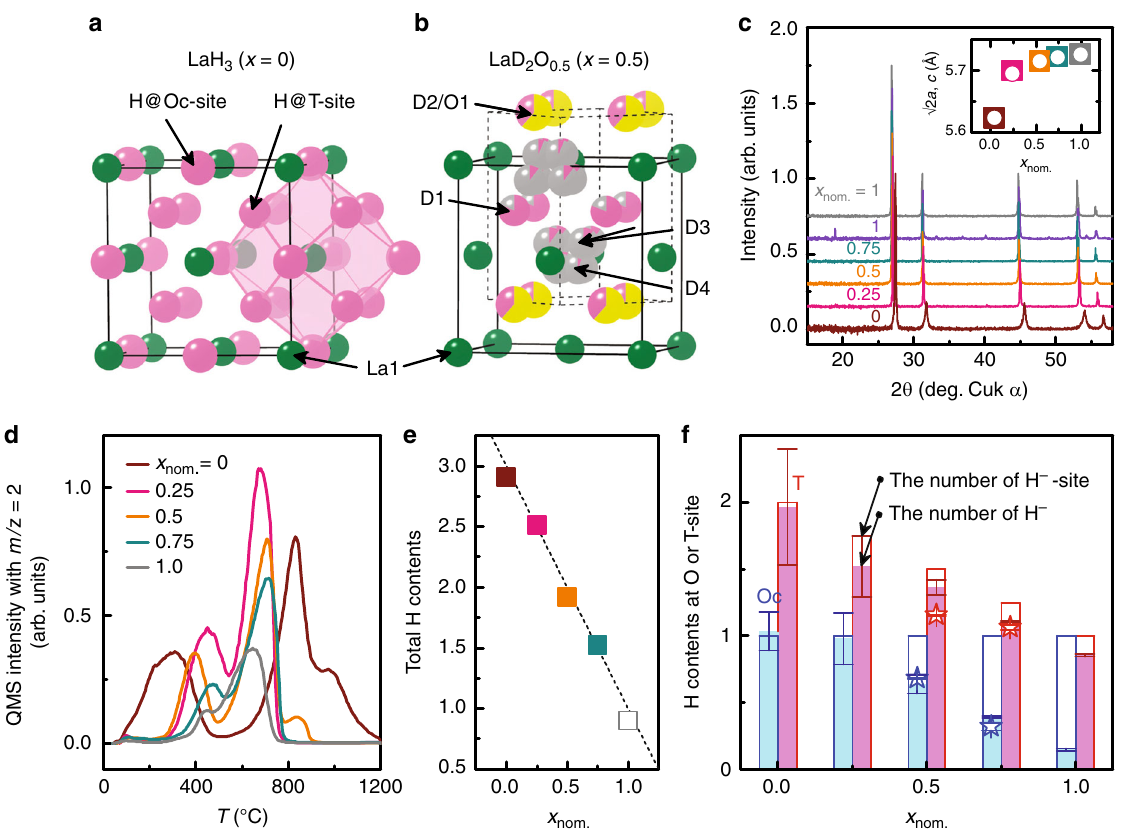
Fig. 1 Structural and compositional analyses for LaH 3-2 x O x and LaD 3-2 x O x . a Crystal structure of LaH 3 . b Crystal structure of LaD 2 O 0.5 determined by NPD. Solid and dashed lines represent the unit cells of the fcc and tetragonal P 4/ nmm structures, respectively. Green, pink, yellow, and gray colors denote the fractions of La 3 + , D − , O 2 − , and vacancies at each crystallographic site, respectively 38 . c x nom dependence of XRD patterns measured after the conductivity measurement heated up to 340 °C. At x nom = 1.0, the pro fi le shown as gray (before conductivity measurement) changes to purple (after conductivity measurement). The inset shows the lattice parameters a multiplied by √ 2 and c as functions of x nom , as obtained from Rietveld re fi nement using the + ). These pro fi les are P 4/ nmm structure. The open circle and fi lled square show √ 2 a and c , respectively. d Thermal-desorption pro fi les of m / z = 2 (H 2 taken from samples after the electrical conductivity measurements, except for x nom = 1, for which the data are collected before the electrical conductivity measurement. e Analyzed hydrogen content as a function of x nom . All values are calculated from the TDS pro fi les shown in panel d . Dashed line is y = 3 − 2 x x x = 0.5 and 0.75 show deuterium content nom . f Hydrogen content at Oc (blue) and T sites (red) as a function of nom . Open star symbols at nom . as obtained by NPD. Open blue and red bars show the calculated available number of Oc and T sites for hydrogen, respectively, assuming that oxygen occupies only T sites. Solid blue and red bars show the number of hydrogen atoms at Oc and T sites measured by TDS, respectively. The error bars show the standard deviation calculated from peak fi